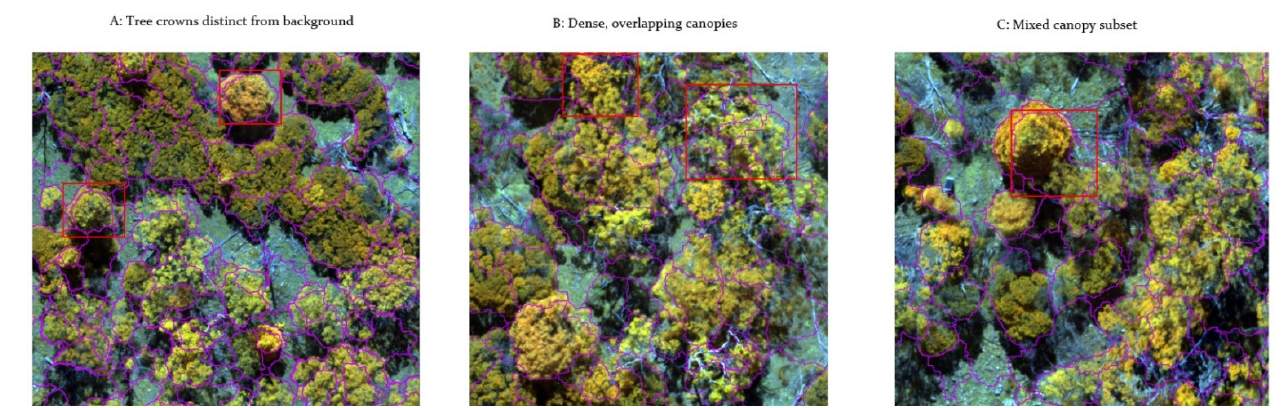
Figure 4. MRS results across different subsets. ( A ) Canopies with a distinct treetop crown structure and with gaps around trees were delineated without excessive oversegmentation or mixing between different classes. ( B ) In overlapping, dense canopies of similar height, there was undersegmentation where different species were represented in a single object. Branching Eucalyptus canopies were oversegmented in all subsets. ( C ) Results for the subset shown in Figure 1. Callitris rhomboidea crown and Eucalyptus pulchella branches erroneously combined in a segment.